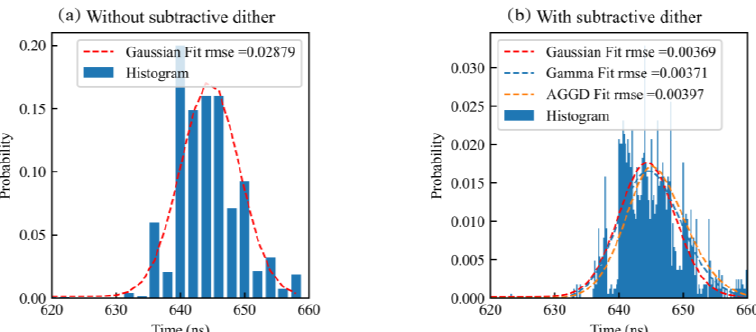
Figure 2. The photon counting histogram at the pixel of (40,40) without denoising and correction. ( a ) without subtractive dither and ( b ) with subtractive dither.